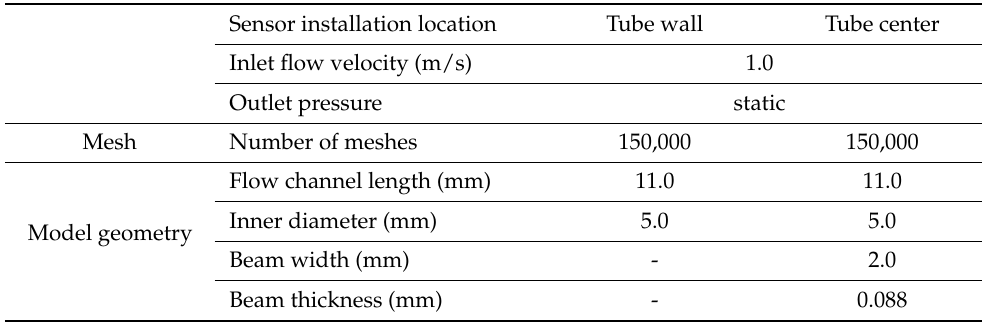
Table 1. Fluid simulation analysis conditions when the sensor is placed on the inner wall of in the center of the